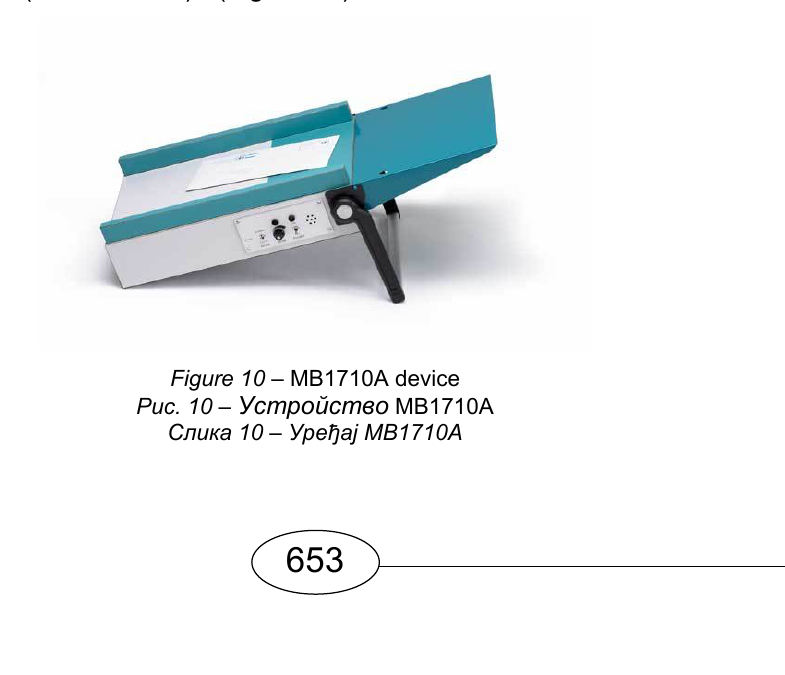
Figure 10 – MB1710A device Рис . 10 – Устройство MB1710A Слика 10 – Уређај